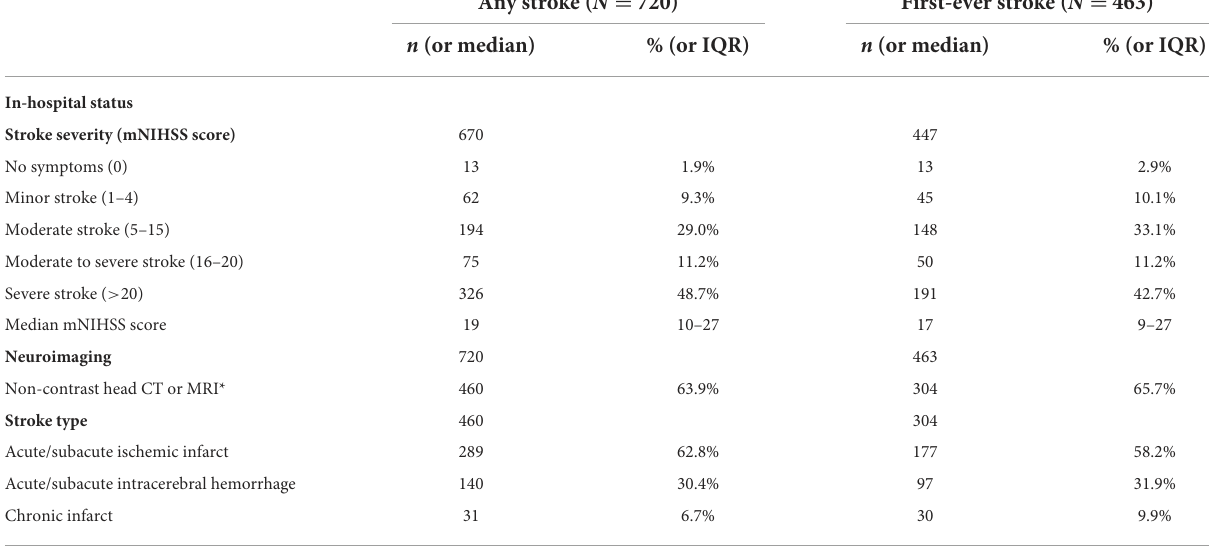
TABLE 4 In-hospital